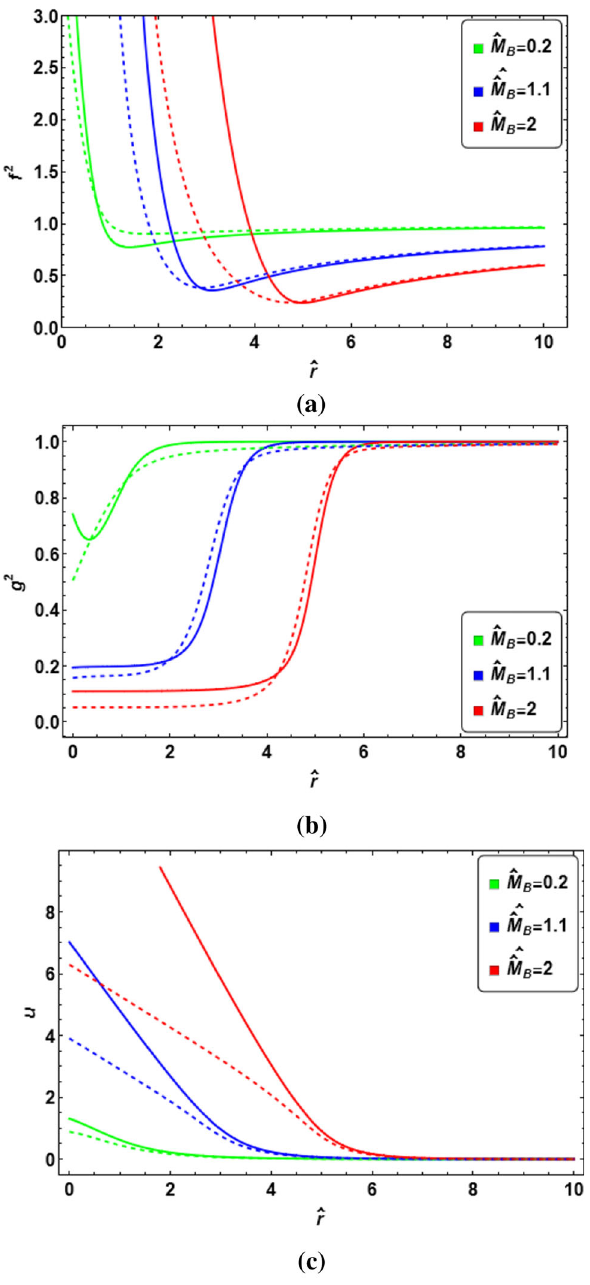
Fig. 2 The spherically-symmetric static EGP system as described by the metric functions f 2 and g 2 , and by the geometric-Proca function u . The plots are produced by setting ˆ M B = 2 and ˆ M D = 0 . 1, and g Y = 0 . 1. The green, blue and red curves correspond to Q D = 0, Q D = 0 . 5 and Q D = 1, respectively. It is clear from the figure that the presence of the charged dust modifies f 2 and g 2 and u drastically from the homogeneous one (green) to particular (blue, red) solutions. This is due to dominance of ρ C at small ˆ